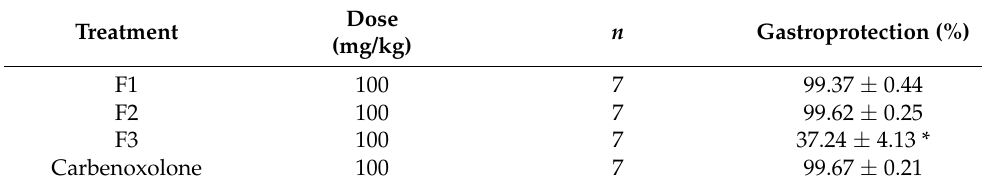
n Gastroprotection (%)